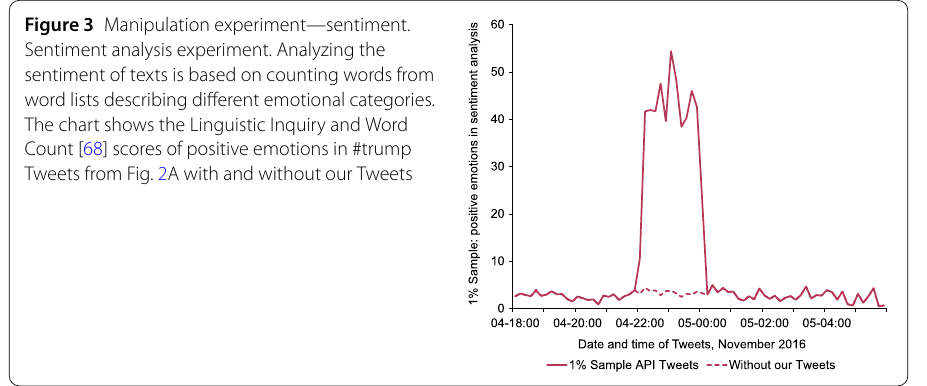
Figure 3 Manipulation experiment—sentiment. Sentiment analysis experiment. Analyzing the sentiment of texts is based on counting words from word lists describing different emotional categories. The chart shows the Linguistic Inquiry and Word Count [68] scores of positive emotions in #trump Tweets from Fig. 2A with and without our